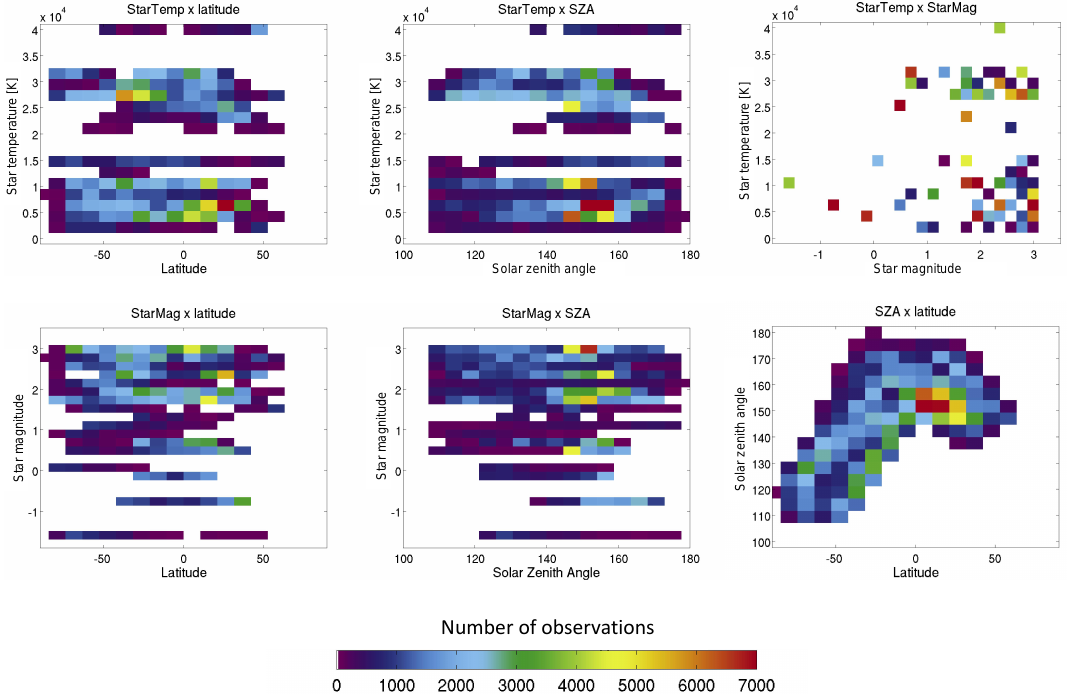
Figure 6. Interdependence of the GOMOS occultation parameters depicted using 2-D histograms of the number of observations for different combinations of occultation parameters (star temperature and magnitude, solar zenith angle and latitude of